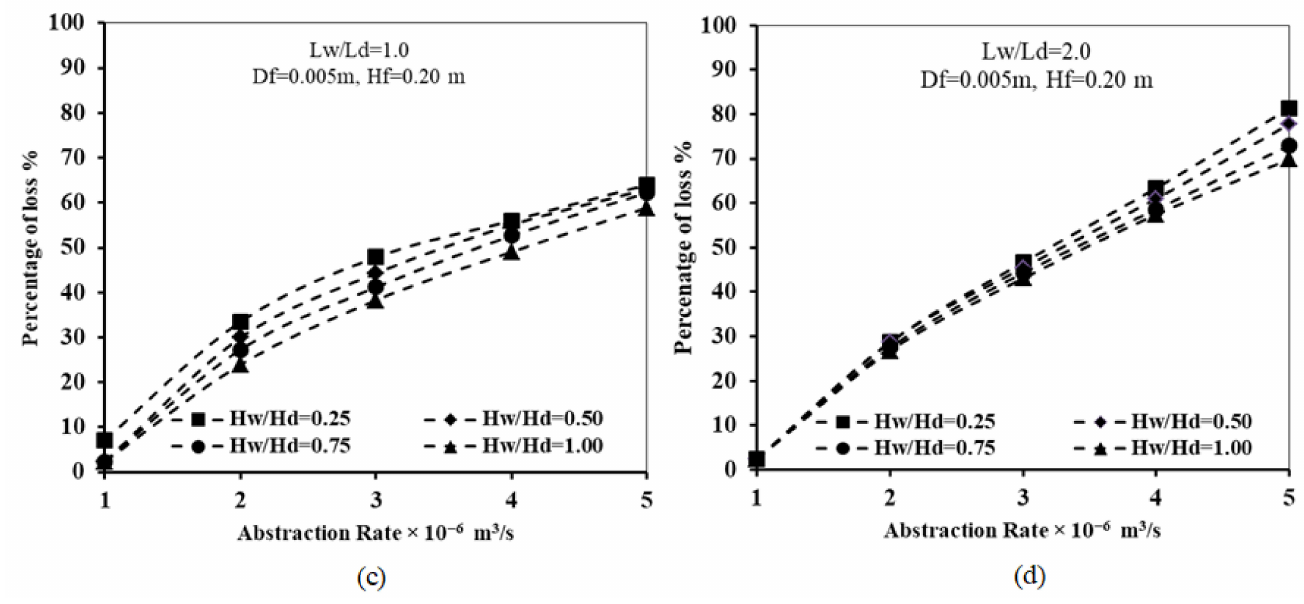
Figure 5. Relation between abstraction well rate and loss of subsurface dam effectiveness for L d = 0.50 m, D f = 0.005 m and for different L w /L d and H f : ( a ) L w /L d = 1.0 and H f = 0.1, ( b ) L w /L d = 2.0 and H f = 0.1, ( c ) L w /L d = 1.0 and H f = 0.2, and ( d ) L w /L d = 2.0 and H f =